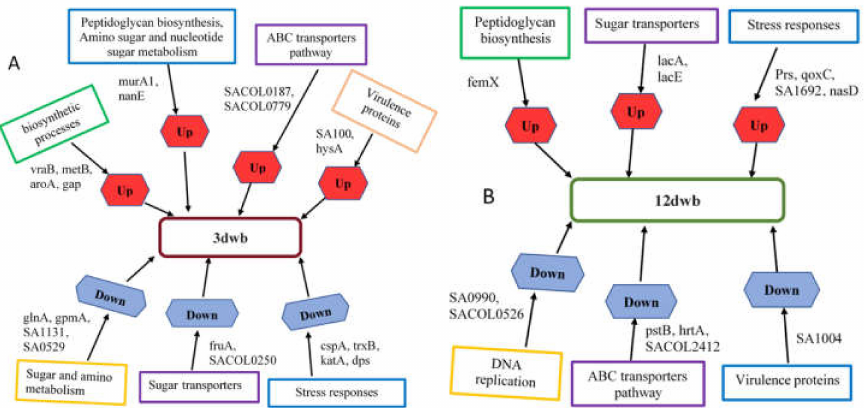
Figure 5. Novel regulators of S. aureus biofilm formation in ( A ) 3-day biofilm, and ( B ) 12-day biofilm identified from TMT-based